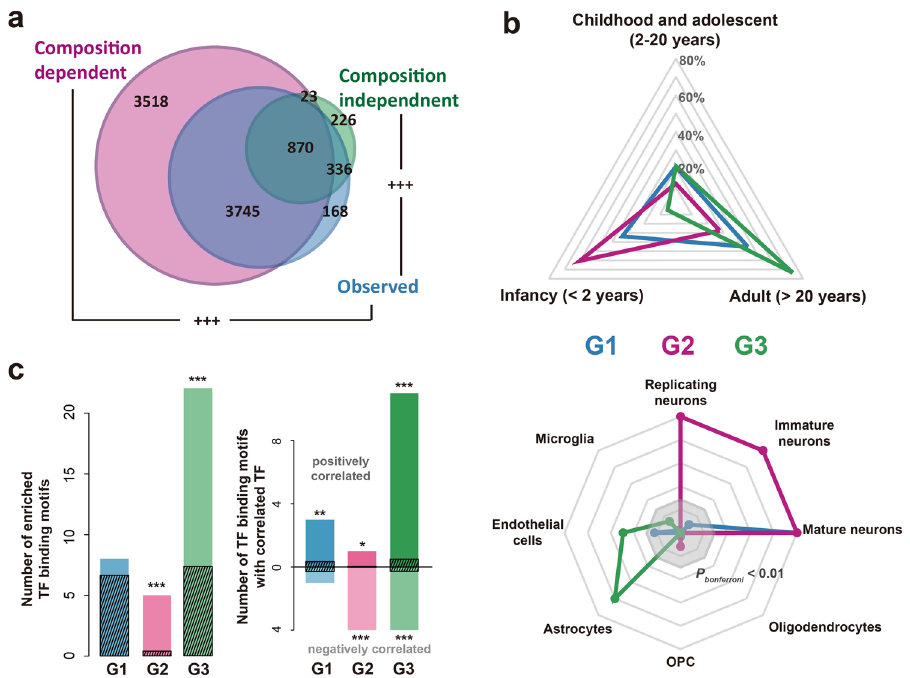
Figure 4. Age-related changes happened in the composition-dependent components and composition- independent components. ( a ) The number of genes with age-related changes in each component or the observed expression level, based on the human postnatal brain data set (blue – observed expression level; pink – composition-dependent component; green – composition-independent component). ( b ) The expression properties of genes with age-related changes in the composition-dependent or composition-independent components. G1 – genes with age-related changes in both components; G2 – genes with age-related changes only in the composition-dependent component; G3 – genes with age-related changes only in the composition- independent component. Top: proportion of genes with highest expression level at each of the three lifespan stages. Bottom: expression enrichment in each of the eight cell types for the three groups of genes, represented as − log10( P ), where P being the p-value of one-sided Wilcoxon’s rank test of log10-transformed fold change from the particular cell type to the remaining cell types, between each of the three groups of genes and all the expressed protein-coding genes. The grey octagonal boxes represent − log10( P ) equaling to values from ten (the outermost box) to two (the inner most box). Strong expression enrichment with − log10( P ) > 10 was presented as ten. ( c ) Regulation of genes with age-related changes in either component by transcription factors (TFs). (Left) the number of TF binding motifs enriched among genes within each group. The dark streaked bars represent the mean number of enriched TF binding sites expected by chance, calculated by 1000 random assignment of the expressed genes into the three groups. (Right) the number of TF binding motifs with its representative TF correlated with the targets (correlated TF binding motifs) in the same group. The dark streaked bars represent the mean number of correlated TF binding motifs expected by chance, calculated by 1000 random assignment of the expressed genes into the three groups. The asterisks show significance of the numbers ( * P < 0.05, ** P < 0.01, *** P < 0.001, Bonferroni